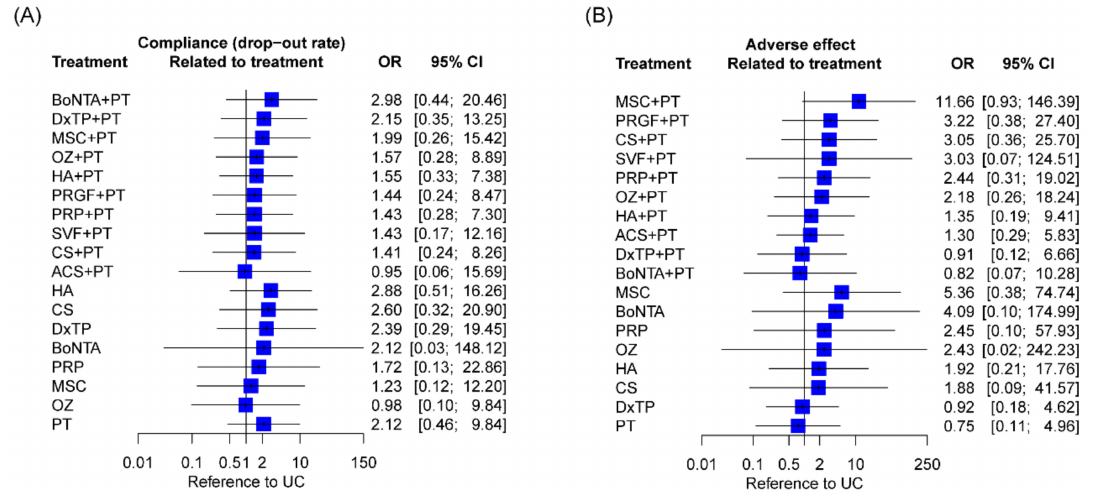
Figure 6. Compliance and adverse events of intra-articular infection regimens. Data concerning treatment-related ( A ) withdrawals and ( B ) adverse events were pooled using inverse variance weighting methods. OR, odds ratio; CI, confidence interval; ACS, autologous conditioned serum; BoNTA, botulinum toxin type A; CS, corticosteroid; DxTP, dextrose prolotherapy; HA, hyaluronic acid; MSC, mesenchymal stem cell; OZ, ozone; PRP, platelet-rich plasma; PRGF, plasma rich in growth factor; PT, physical therapy; SVF, stromal vascular fraction; UC, usual